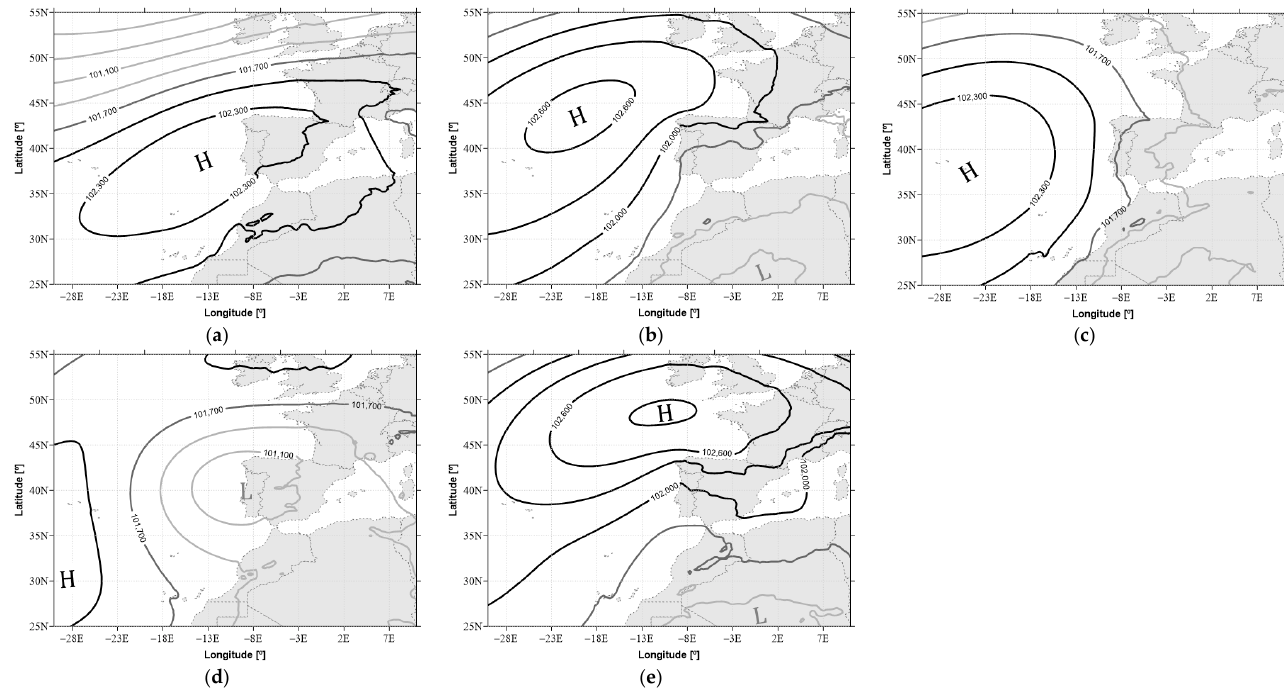
Figure 7. Mean sea level pressure (Pa) contour maps representative of the five most dominant weather circulation types over the region under study for the period from 1980 to 2018: ( a ) “H”—high pressure (anticyclonic), ( b ) “NE”—northeast circulation, ( c ) “N”—north circulation, ( d ) “L”—low pressure, and ( e ) “E”—east circulation. The contour lines are gradational by color (grey—low-pressure areas, black—high-pressure areas) and equally spaced by 300 (Pa). The letters H and L in all images identify the center with high- or low-pressure